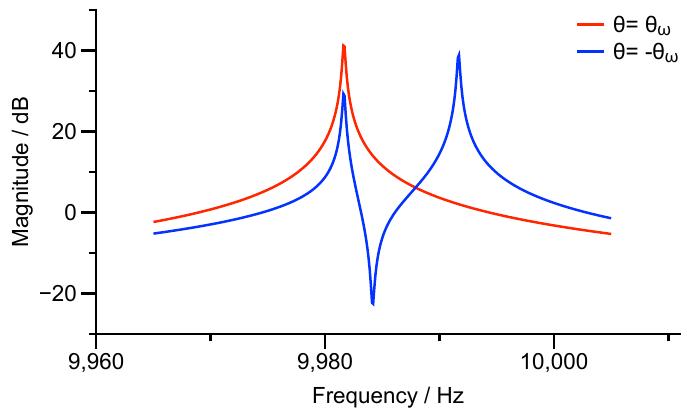
Figure 5. Magnitude-frequency responses of T 11 ( s , θ ω ) and T 11 ( s , − θ ω ) .